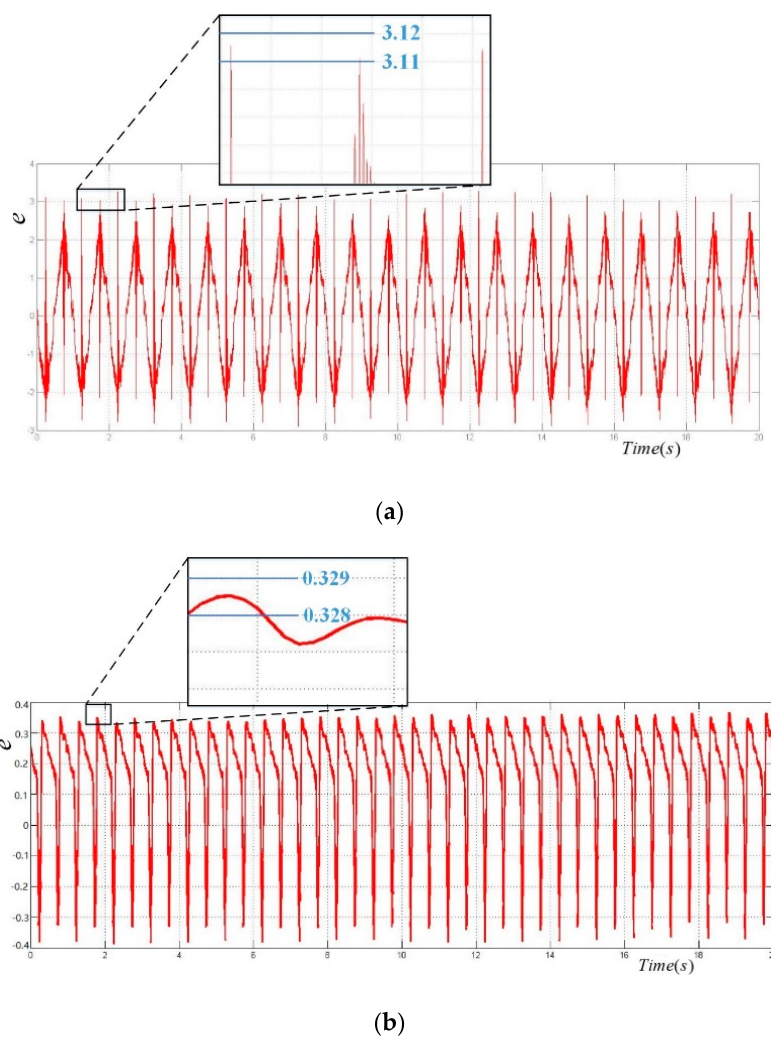
Figure 22. Coarse–fine composite mechatronic controller disturbance suppression deviation output. ( a ) The deviation value between the USM coarse stage controller encoder feedback curve and the sinusoidal wave disturbance curve. ( b ) The deviation value between the VCM fine stage controller Hall e ff ect sensor feedback curve and the deviation curve (compensated error) between the USM coarse stage controller encoder feedback curve and the sinusoidal disturbance